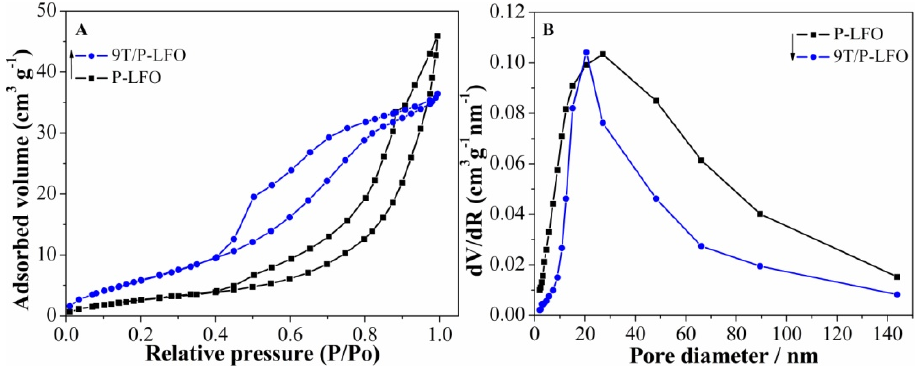
Figure 4. N 2 adsorption/desorption isotherms ( A ) and pore diameter ( B ) of P-LFO and 9T/P-LFO Figure nanocomposite.